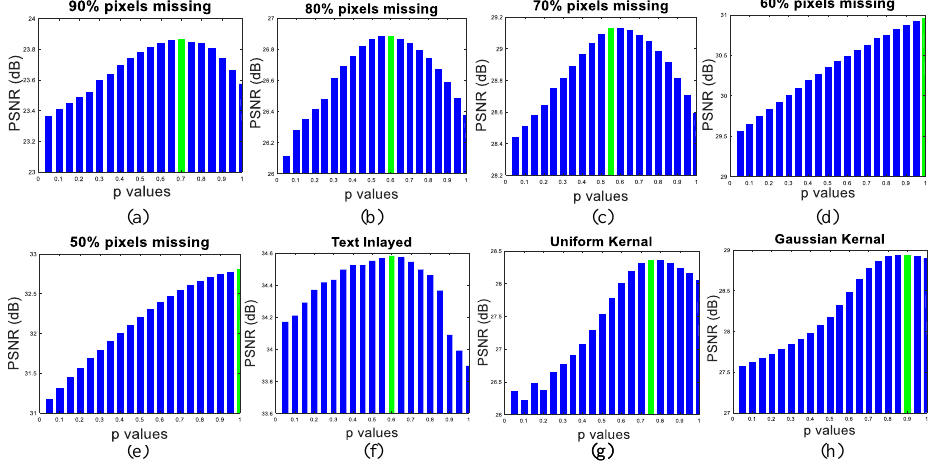
Figure 8. Testing the different power p value for the influence of image restoration tasks. ( a – f ) PSNR values versus p for image inpainting; ( g , h ) PSNR values versus p for image